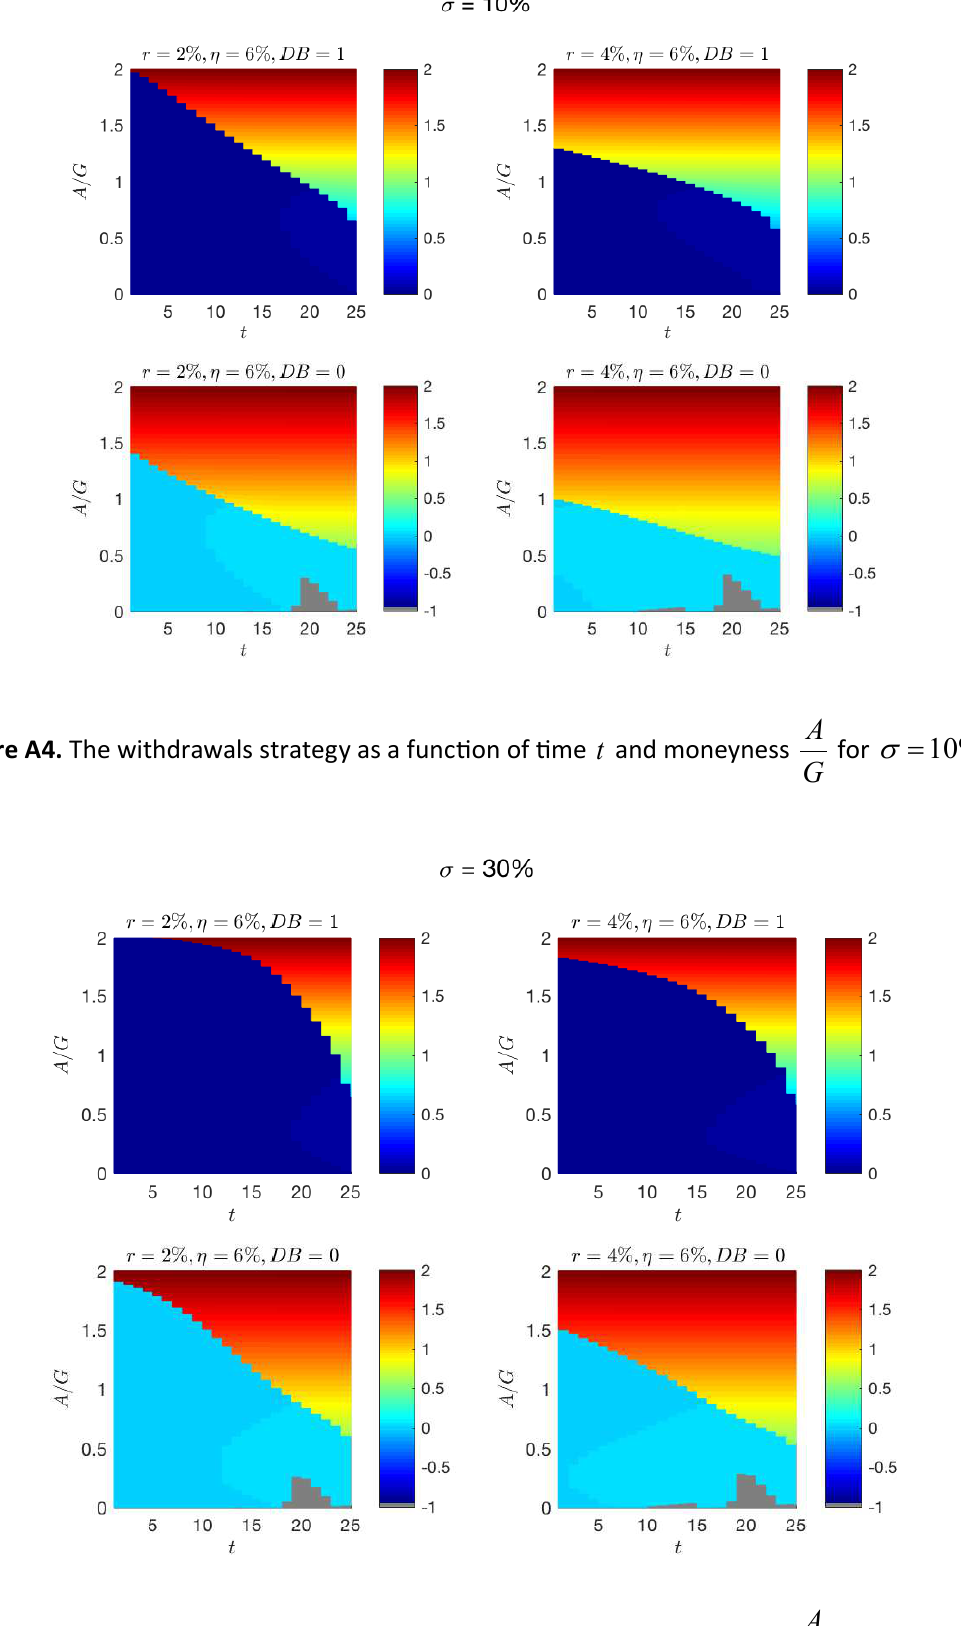
Figure A5. The withdrawals strategy as a function of time t and moneyness